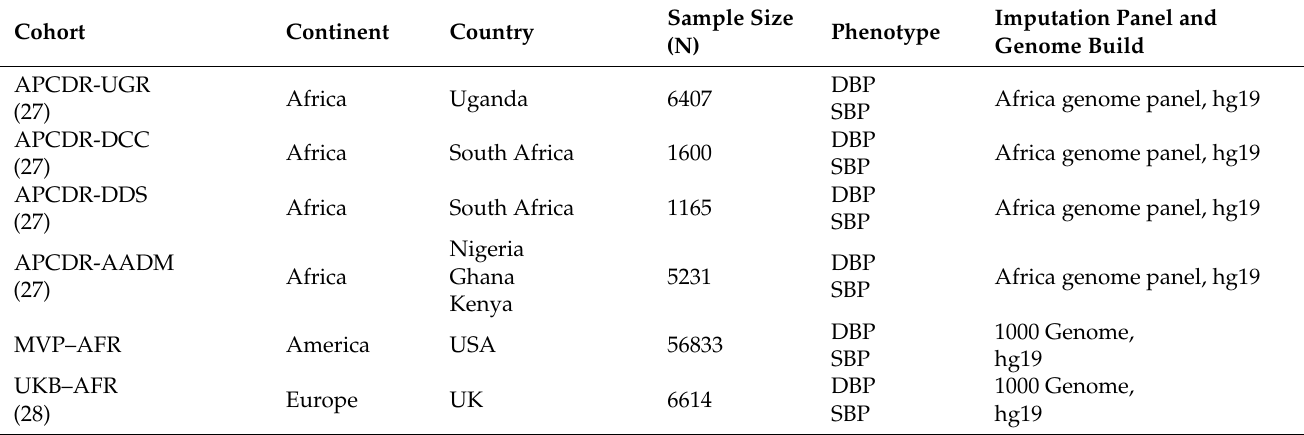
Table 1. Description of cohorts used in this